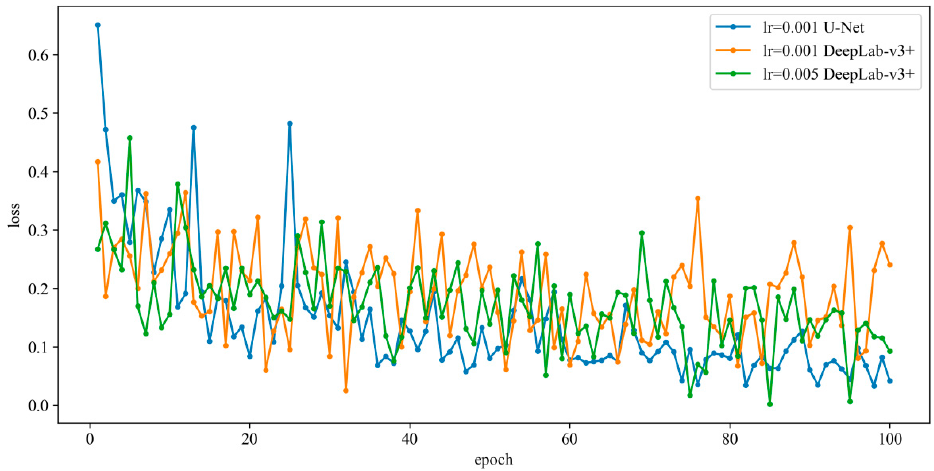
Figure 17. Loss of U-Net and DeepLab-v3+.